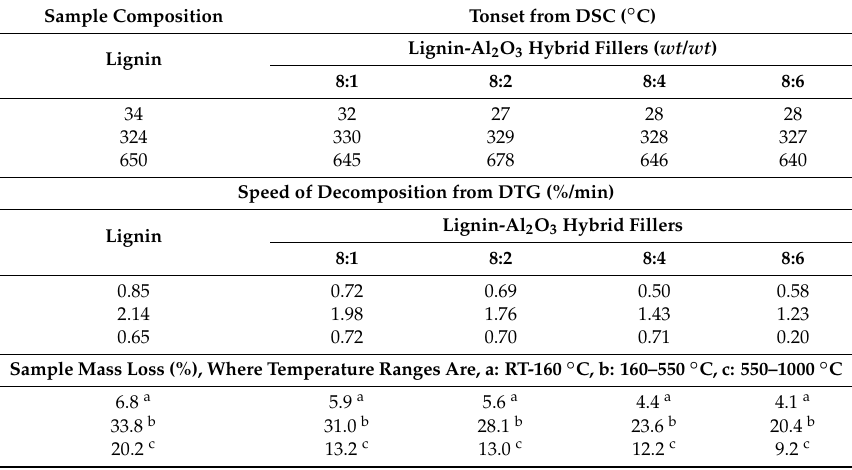
Table 3. Comparison of lignin and different lignin-Al 2 O 3 composition collected during thermal decomposition of samples. DTG and Tp are first derivative of sample mass loss signal and peek temperature, respectively.